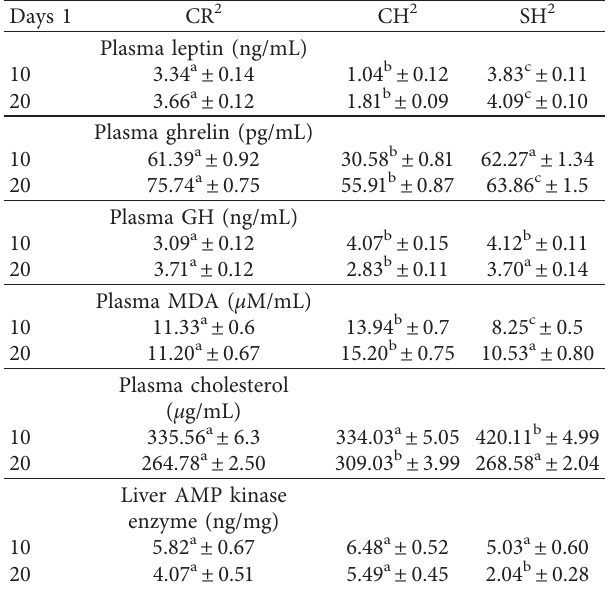
Table 5: Feed intake (g) of Nicobari chickens subjected to different treatments.